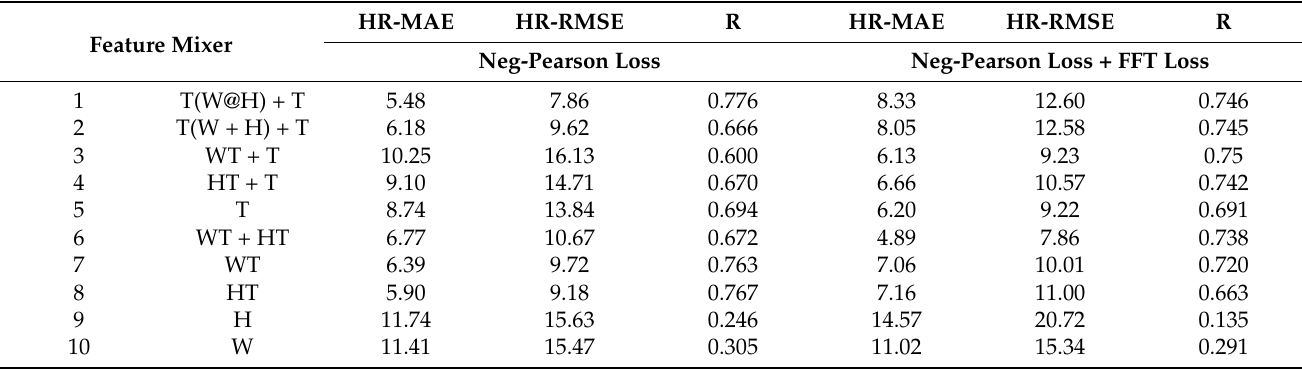
Table 5. Evaluation results for 10 feature mixers using the V4V dataset.